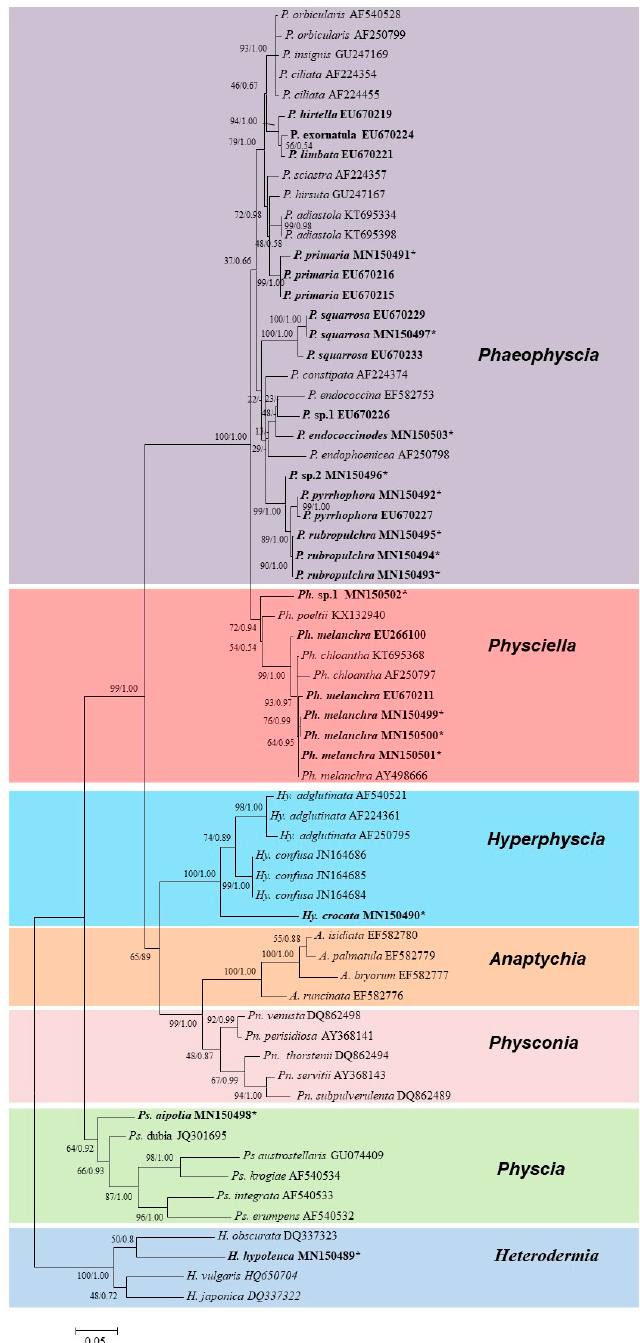
Figure 2. Consensus tree showing the phylogenetic relationships among the species in the family Physciaceae based on ITS sequence by ML and Bayesian inference. The related species of Phaeophyscia , Physciella , and Hyperphyscia are depicted. The ML bootstrap (before the slash) and posterior probabilities are given adjacent to the nodes. The phylogenetic tree was rooted by the species Heterodermia . Specimens from South Korea are in bold; the asterisk refers to the newly generated sequences in this study. A. = Anaptychia , Hy. = Hyperphyscia , P. = Phaeophyscia , Ph. = Physciella , Pn. = Physconia , and Ps. =